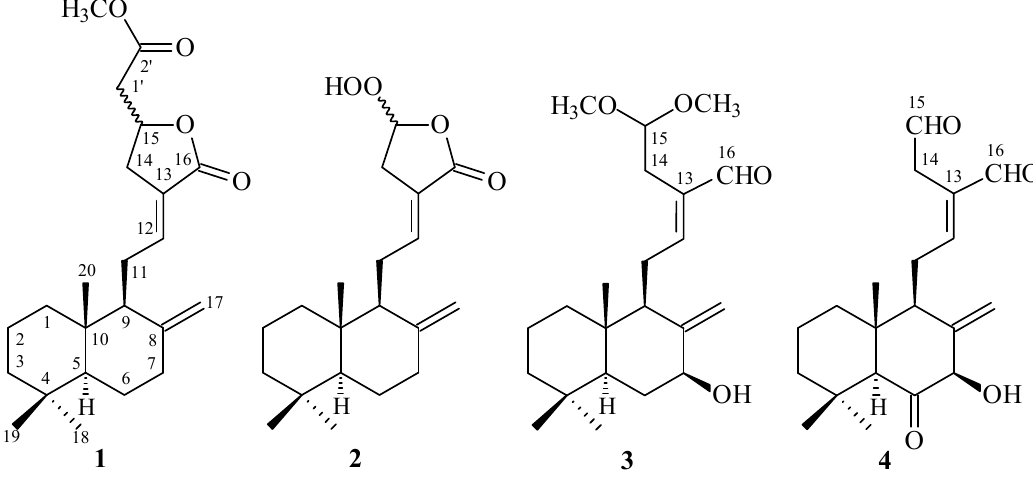
Figure 1. The chemical structures of new compounds 1 – 4 isolated from H. coronarium